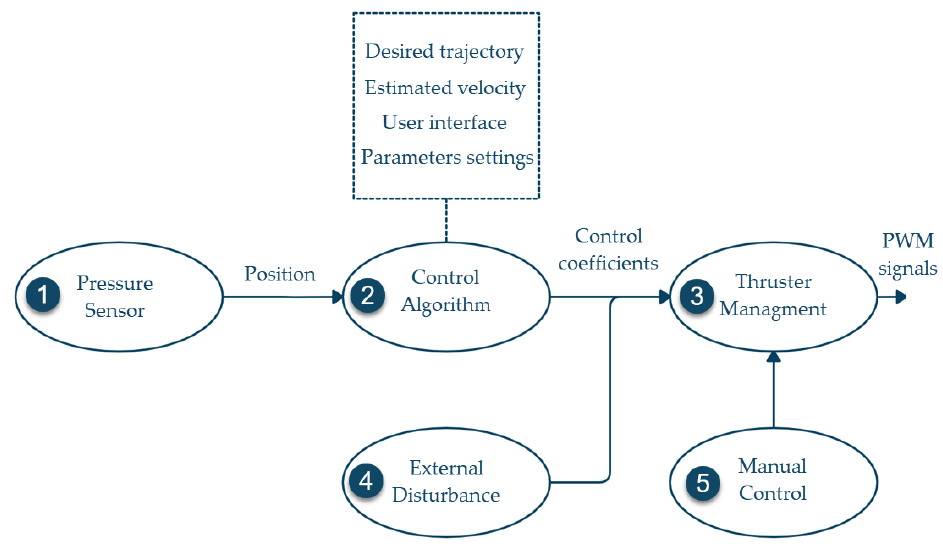
Figure 6. BlueROV2 software configuration.